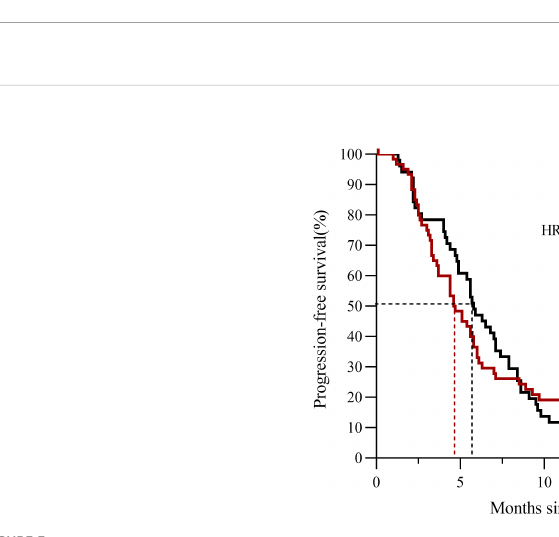
prospective phase II study, raltitrexed combined with S-1 treated metastatic colorectal cancer after the failure of